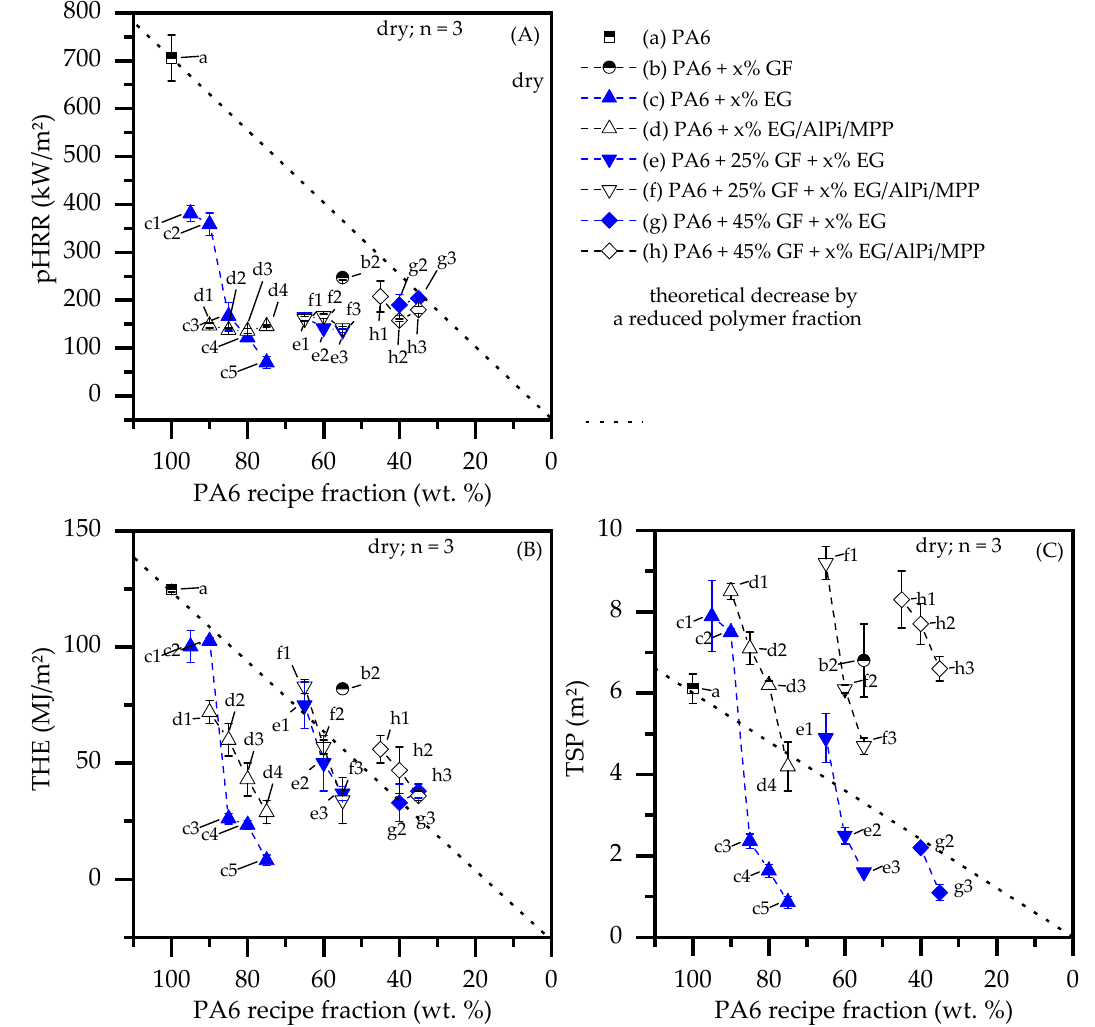
Figure 7. Comparison of major cone calorimeter (50 kW/m 2 ) key figures applied over the PA6 matrix fraction. ( A ) peak heat release rate (pHRR); ( B ) total heat emitted (THE); ( C ) total smoke production (TSP). Table 2. Summary of cone calorimeter fire testing results; 50 kW/m 2 .